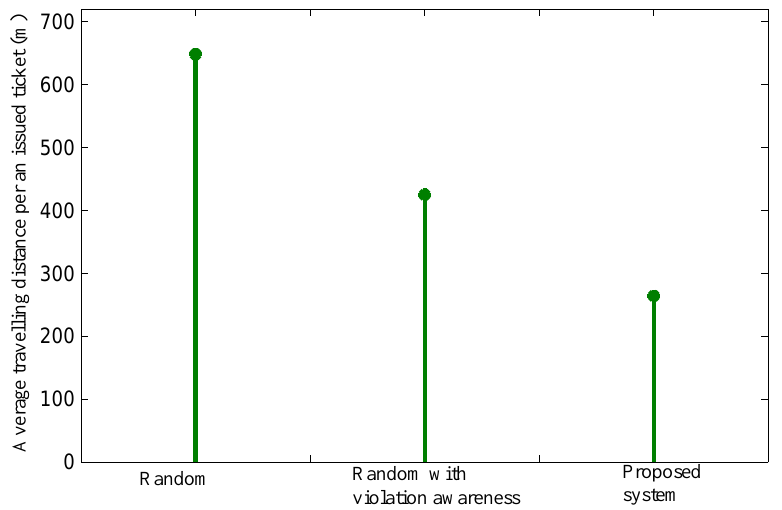
Figure 15. Average travelling distance of officers per an issued ticket in regions with high violation volumes.